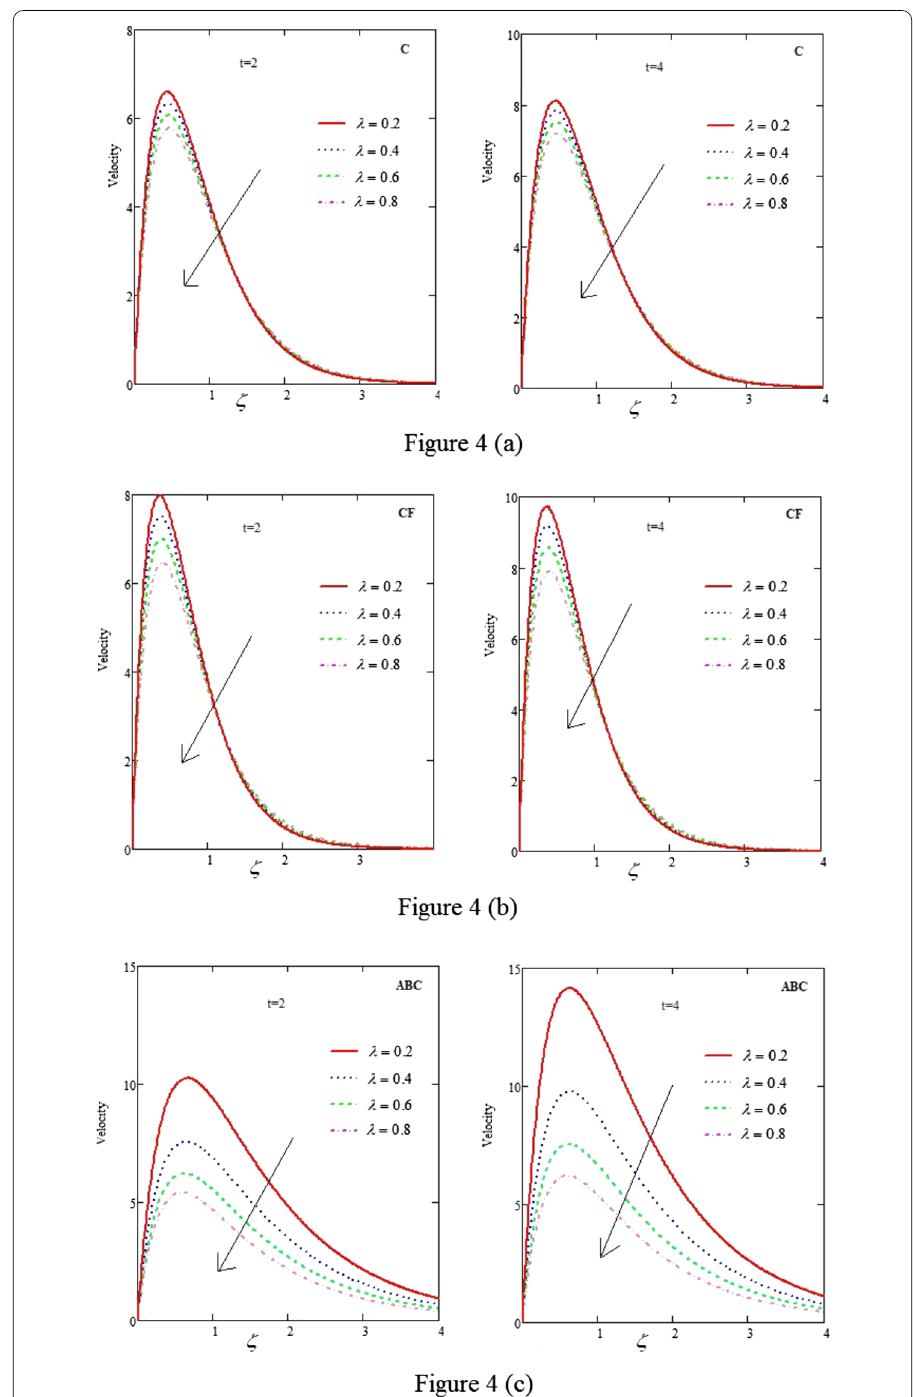
Figure 4 ( a , b , c ). Velocity curves belonging to C, CF and ABC for various values of λ , where γ = 0.1, Pr = 6, Sc = 8, Gr = 6, Gm = 8 and M =